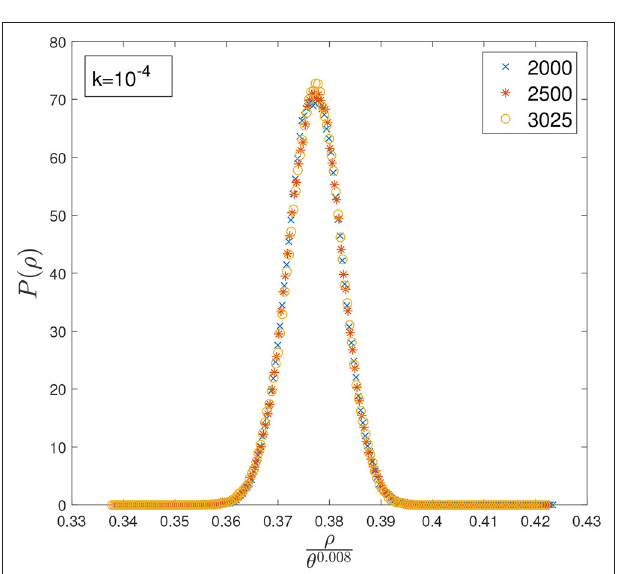
FIGURE 3 | Distribution of densities P ( ρ ) computed at different values of θ and k = 10 − 4 . Although rescaling the x-axis by θ 0.008 seems to make it possible to perform a data collapse for θ ∈ [2000,3025], this does not hold for larger values of θ